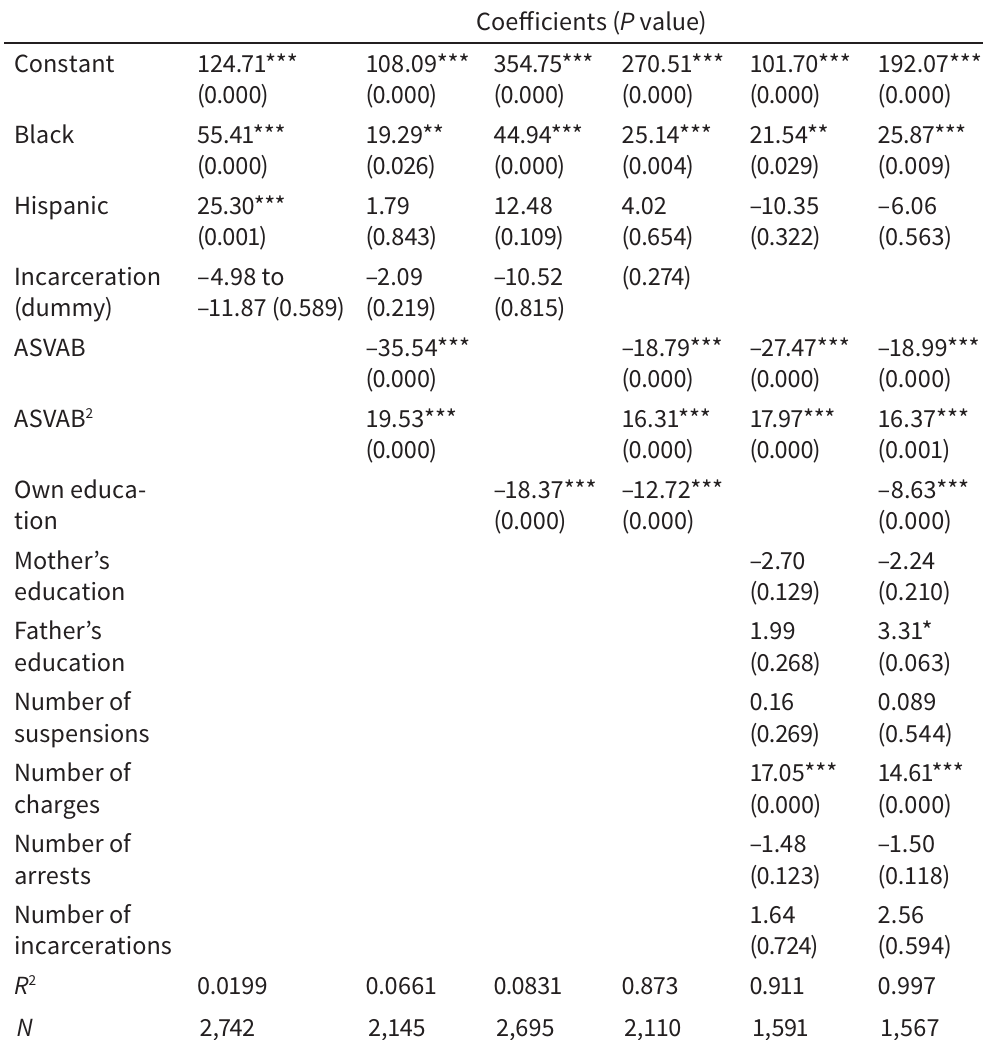
Ordinary least squares regression, weeks not working,